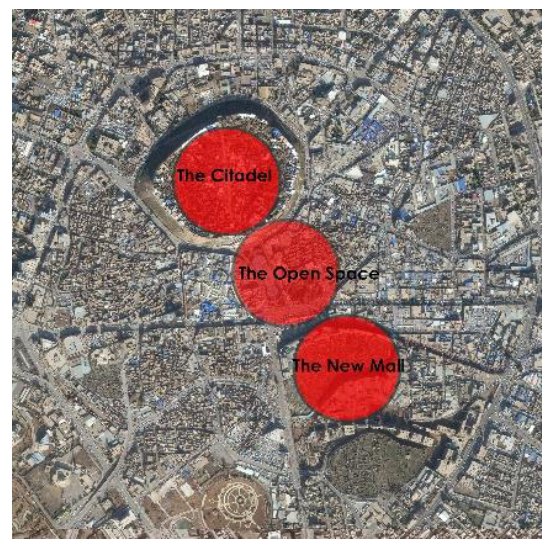
Figure 4 .Both side of the new square development with sharp